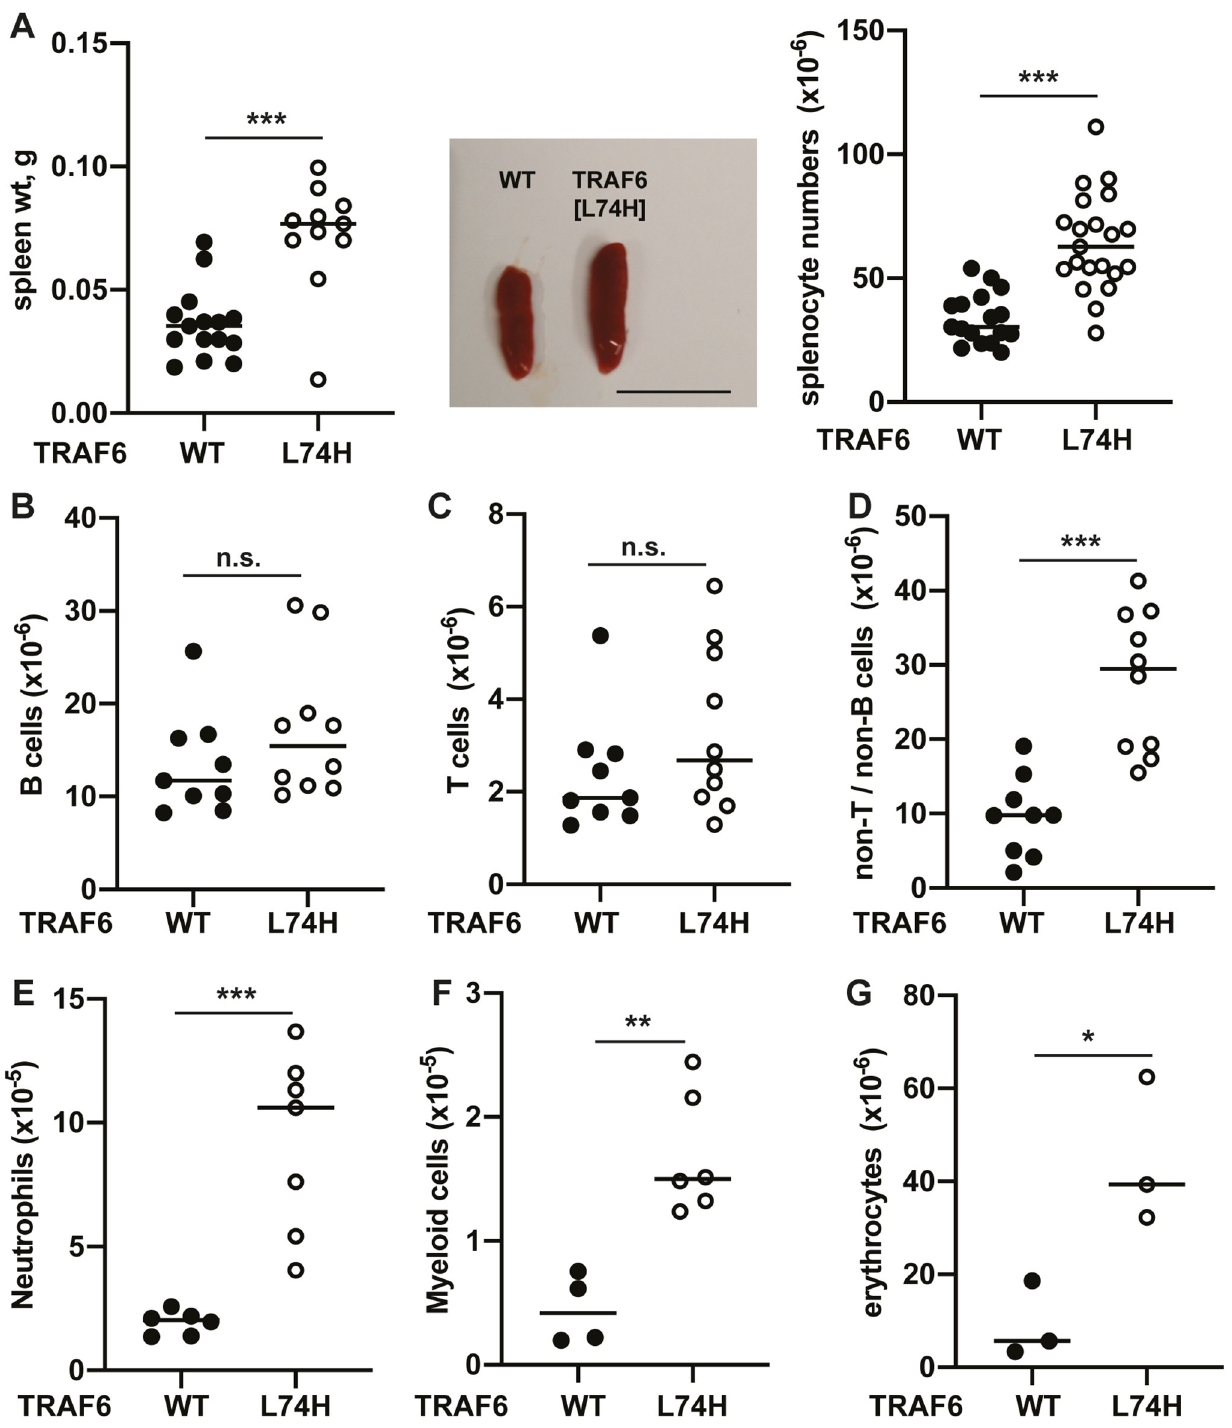
Fig 2. Characterization of splenic immune cell populations in TRAF6[L74H] mice. (A) Spleen weight (left panel) and representative images of spleen enlargement (middle panel) and total splenocyte numbers of 16 days old WT (n = 15–17) and TRAF6[L74H] (n = 11–21) mice, scale bar = 1 cm. (B-D) Immune cell populations in the spleen of 16 days old WT and TRAF6[L74H] mice were analyzed by flow cytometry. Total numbers of (B) B-cells, (C), T- cells, (D) and non-T/B cells in spleens of WT (n = 9) and TRAF6[L74H] (n = 10) mice are shown. (E-G), as in B-D, except that (E) neutrophils from WT (n = 6) and TRAF6[L74H] (n = 7) mice (F) Gr-1 - CD11b + myeloid cells from WT (n = 4) and TRAF6[L74H] (n = 6) mice or (G) erythrocytes WT (n = 3) and TRAF6[L74H] (n = 3) mice were measured. Symbols represent individual biological replicates. Statistical significance between the two genotypes was calculated using the unpaired t-test with Welch’s correction or the Mann-Whitney test. � denotes p < 0.05, �� denotes p < 0.01, ��� denotes p < 0.001 and n.s. denotes not significant difference. Individual values, descriptive statistics and results from the statistical analysis are provided in S2 File.